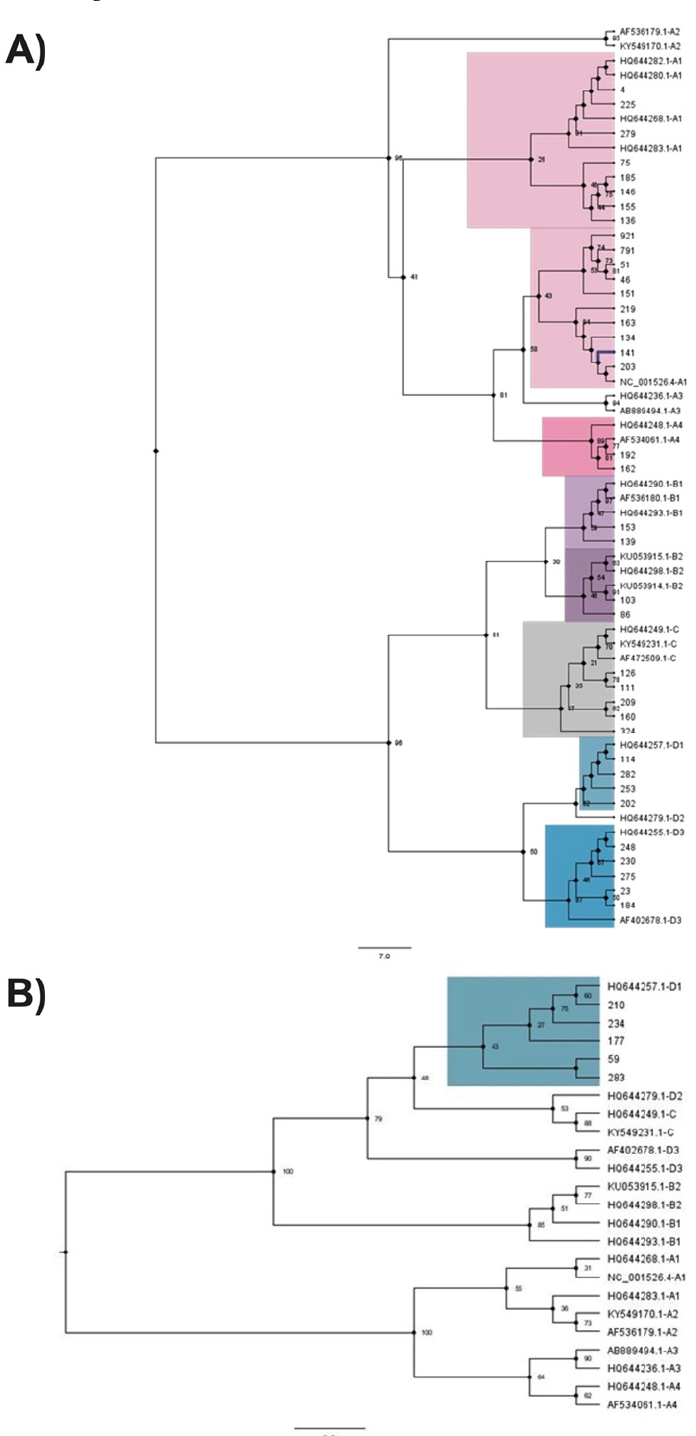
Figure 3. HPV16 phylogenetic trees. ( A ) Maximum likelihood analysis of the E6 nucleotide sequence. Specimens that did not cluster to any reference sequence were excluded. ( B ) Excluded specimens with complete L1 genes were reanalyzed by using maximum likelihood of the L1 nucleotide sequence. Numbers on the nodes indicate bootstrap